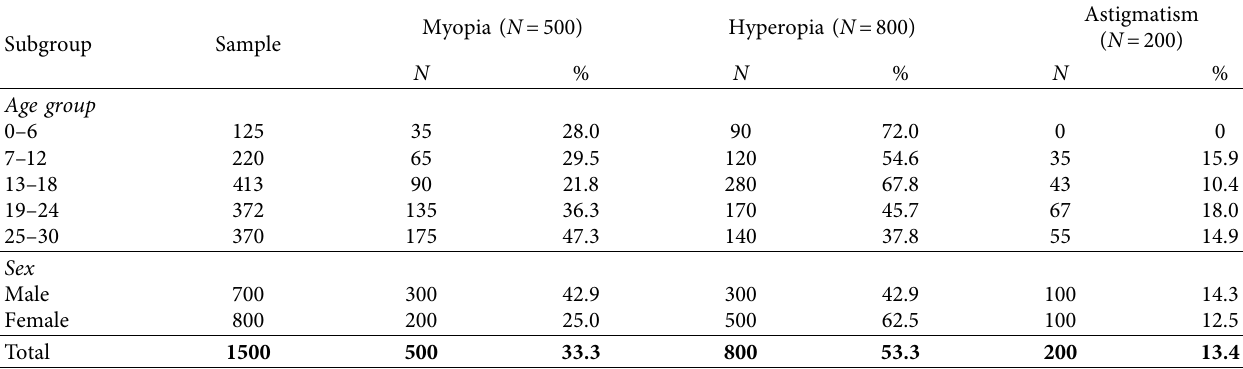
Table 1: Age and sex distribution of different types of refractive errors in a Yemeni population 0–30 years ( N � 1,500)